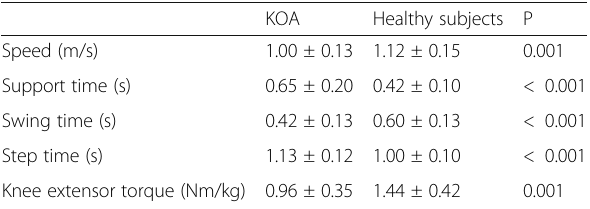
Table 2 Comparison of gait kinematic variables and quadriceps strength in subjects with KOA and healthy subjects KOA Healthy subjects P